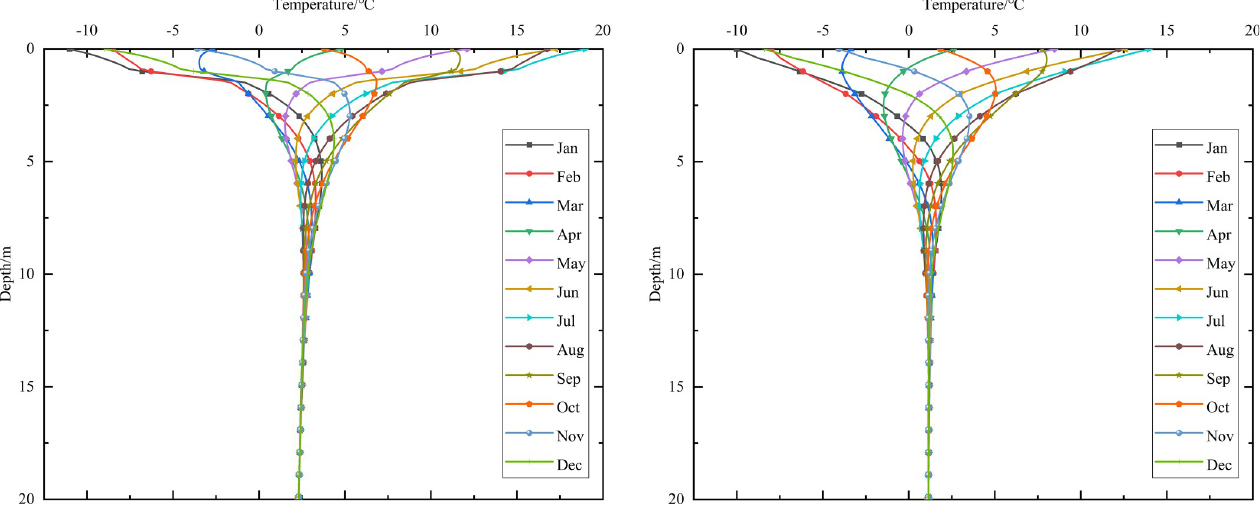
Fig 7. Temperature-depth curves at the (a) pavement center and (b) natural surface center.